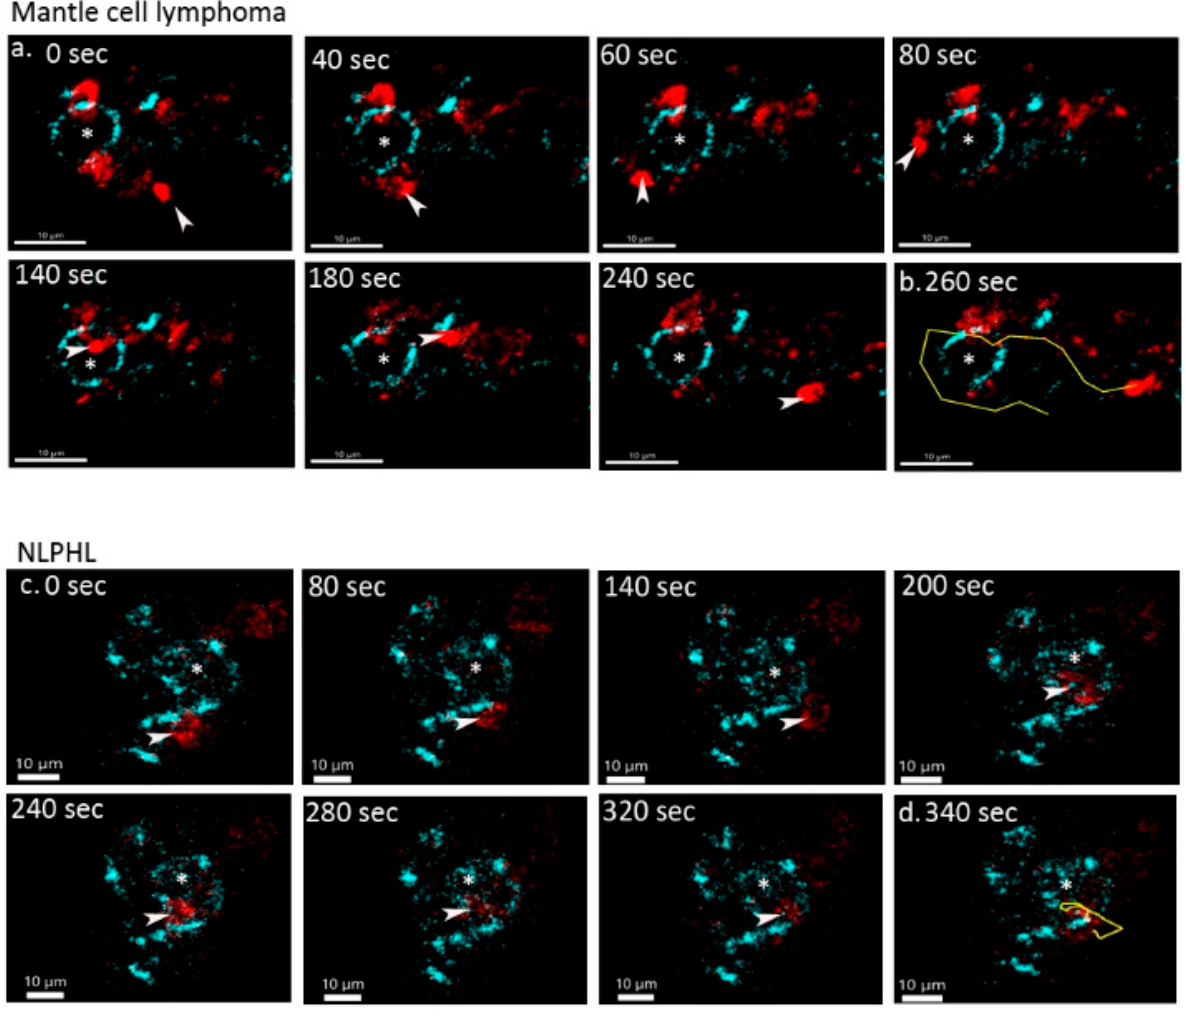
Figure 4. Variable duration of cell–cell contacts in different lymphomas. ( a ) Time lapse images of a PD1-positive T cell (red, marked by arrow head) undergoing a short contact with a CD20-positive lymphoma cell (blue, marked by *) in mantle cell lymphoma. ( b ) Track (yellow) of the PD1-positive T cell from the mantle cell lymphoma from a. ( c ) Time lapse images of a PD1-positive T cell (red, marked by arrow head) undergoing a long dynamic contact with a CD20-positive lymphoma (LP) cell (blue, marked by *) of NLPHL. ( d ) Track (yellow) of the PD1-positive T cell from the NLPHL from c.